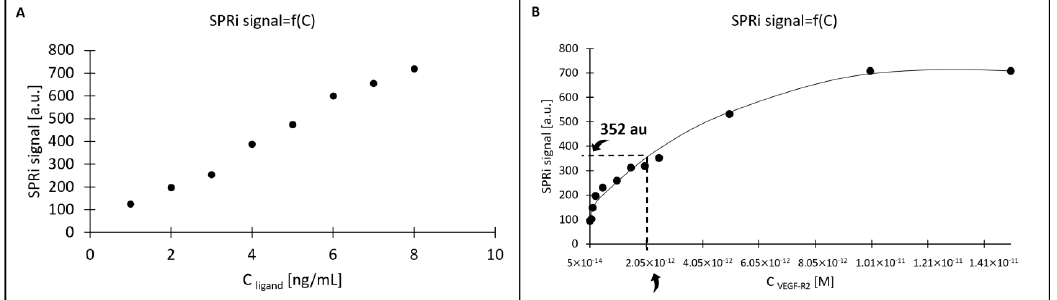
Figure 8. Curves for the determination of thermodynamic parameters by the SPRi method. ( A ) the detector’s response to the introduced ligand at various concentrations; ( B ) determination of the K D value by SPRi.